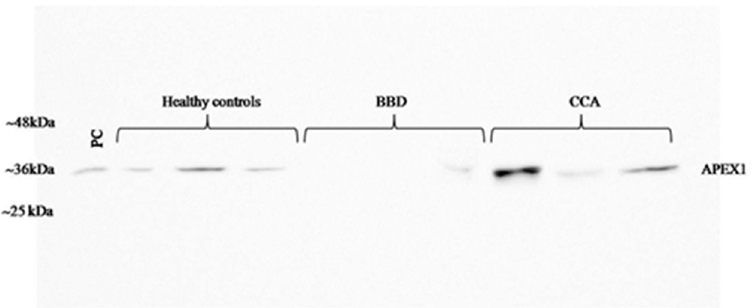
Figure 2. Validation of the selected candidate protein, APEX1 in serum samples by western blot analysis. BBD: benign biliary diseases.